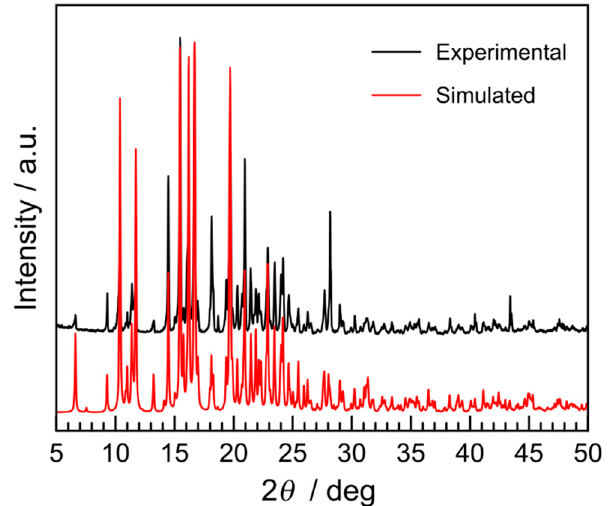
Figure 2. Experimental powder X-ray diffraction (PXRD) pattern of 1 (black) at room temperature (RT) compared with the simulated pattern from the single crystal X-ray data at 296 K (red).